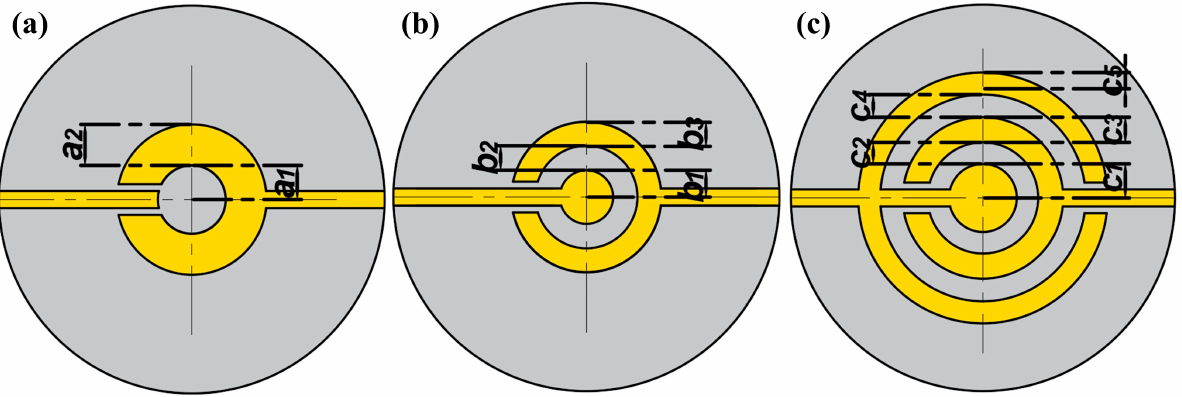
Figure 2. Structure of interdigital electrode. ( a ) Single finger electrode. ( b ) Dot finger electrode. ( c ) Dot double-finger electrode.